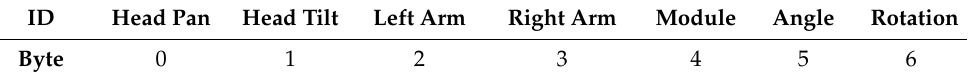
Table 3. Structure of an UDP motors control packet.